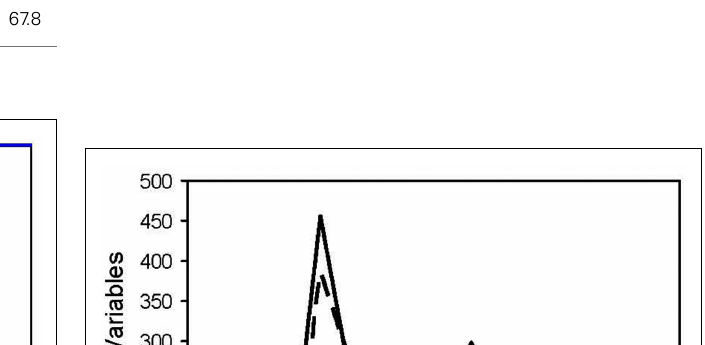
FIGUREA2 | Histogram of two log normal distribution. The solid line has a mean of 1 and the dotted line has a mean of 1.225 where the difference in the means yields ∼ 100% power for MDMR with a two log normal population distributions.